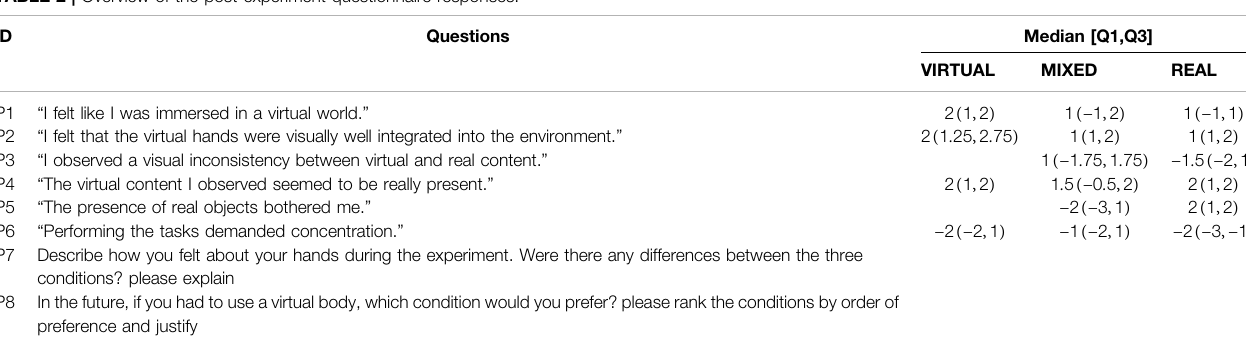
TABLE 2 | Overview of the post-experiment questionnaire responses.